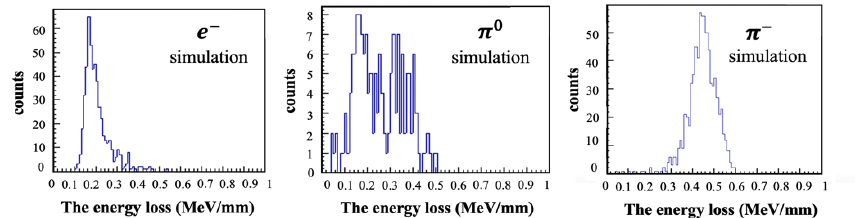
Fig. 5. The energy deposit per path length in the plastic counter for the beta-decay electron, π & and π ’